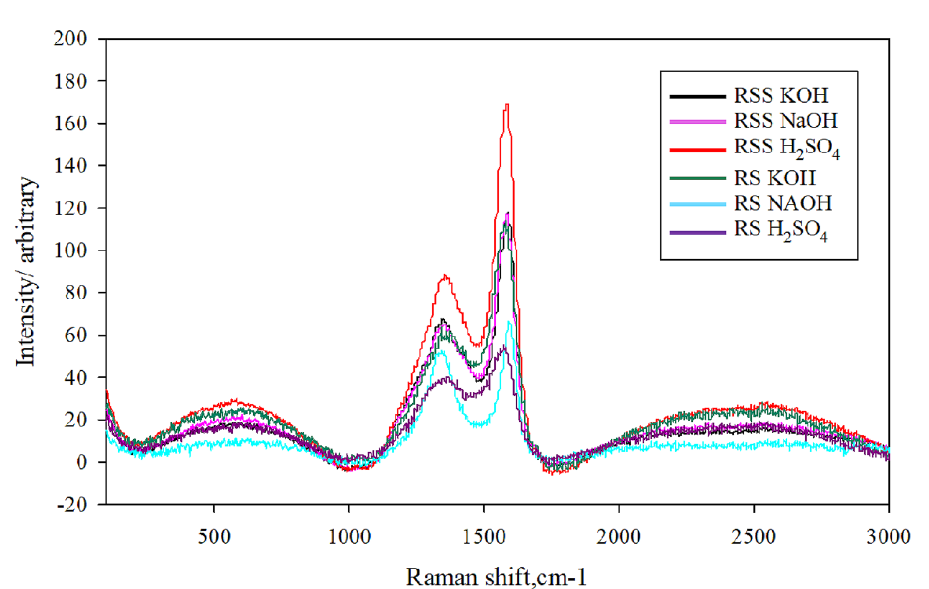
Figure 5. Raman spectroscopy of PAC using various activation